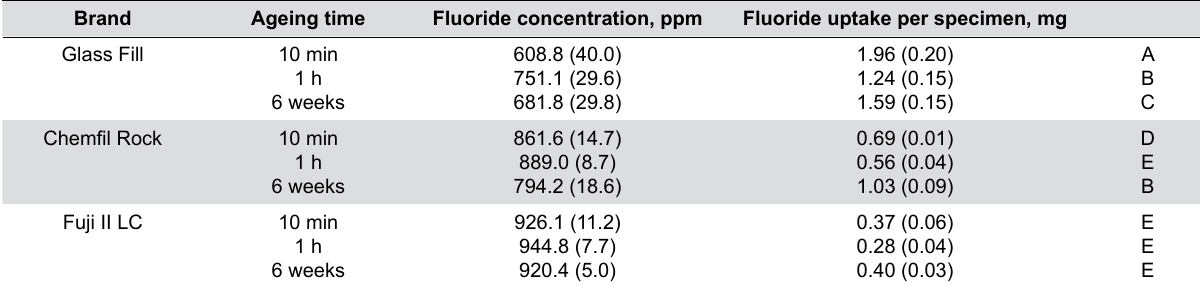
Table 2- Fluoride uptake by specimens (groups that do not differ significantly are indicated with the same letters)